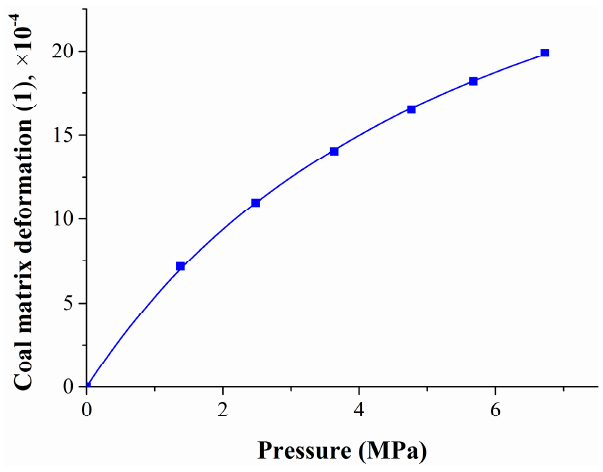
Figure 4. Relationship between coal matrix deformation and the methane pressure.